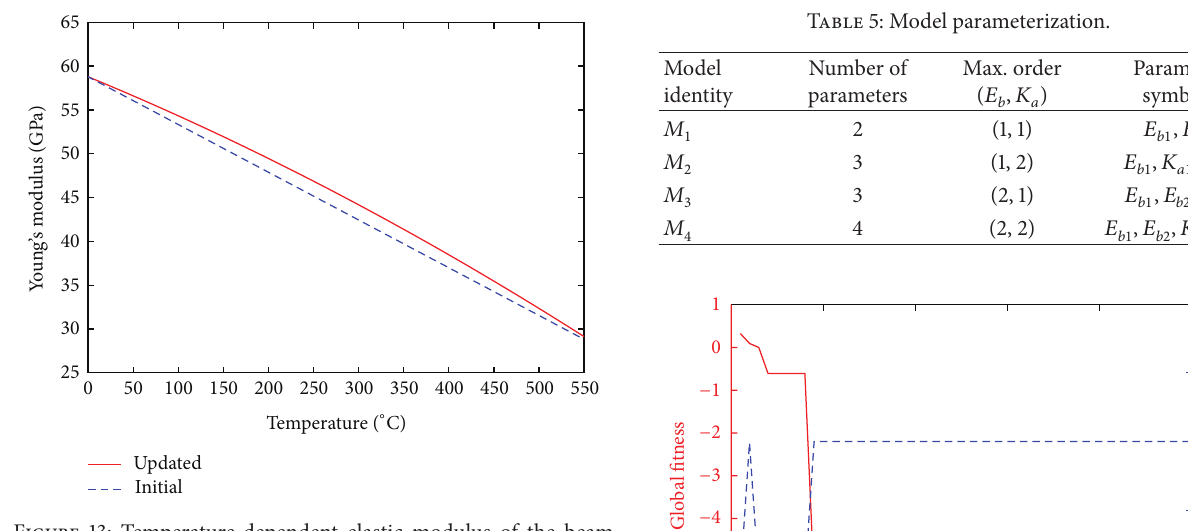
Figure 13: Temperature-dependent elastic modulus of the beam material.